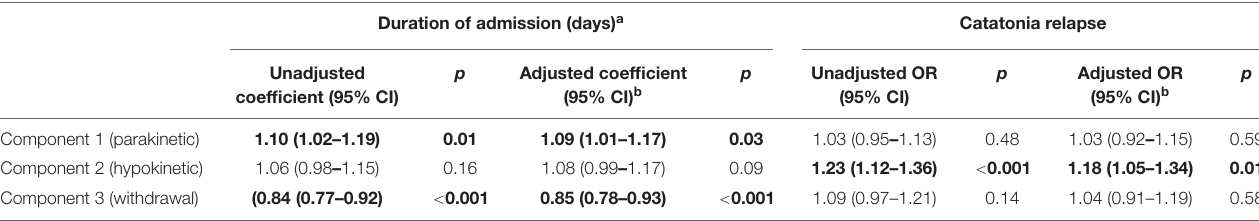
TABLE 4 | Linear regression of duration of admission on principal components and logistic regression of subsequent catatonia relapse on principal